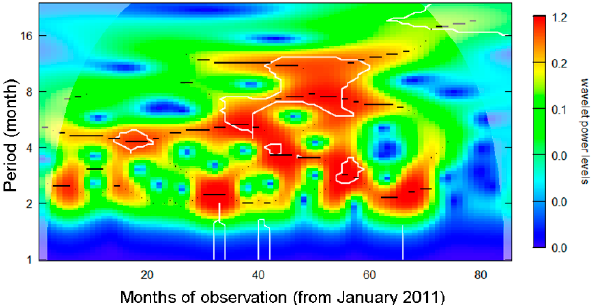
Figure 2. Wavelet power spectrum analysis of blood culture positives with Bacillus spp from 2011–2016. Horizontal axis counts month since January 2011. High power density indicates possible periodic occurrence of blood culture positives. For instance, red hot spot at 12-month period from 2013–2016 supports annual cyclical behavior during the corresponding period.